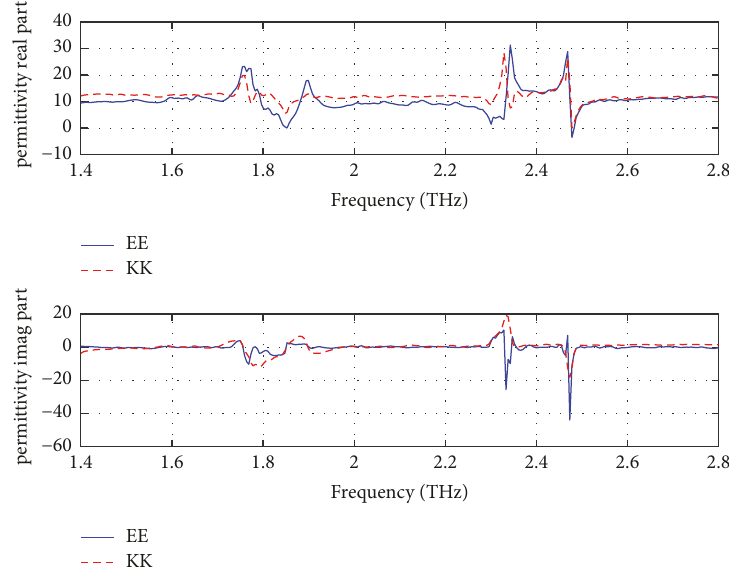
Figure 16: The comparison between the extracted permittivity and Kramers-Kronig results.